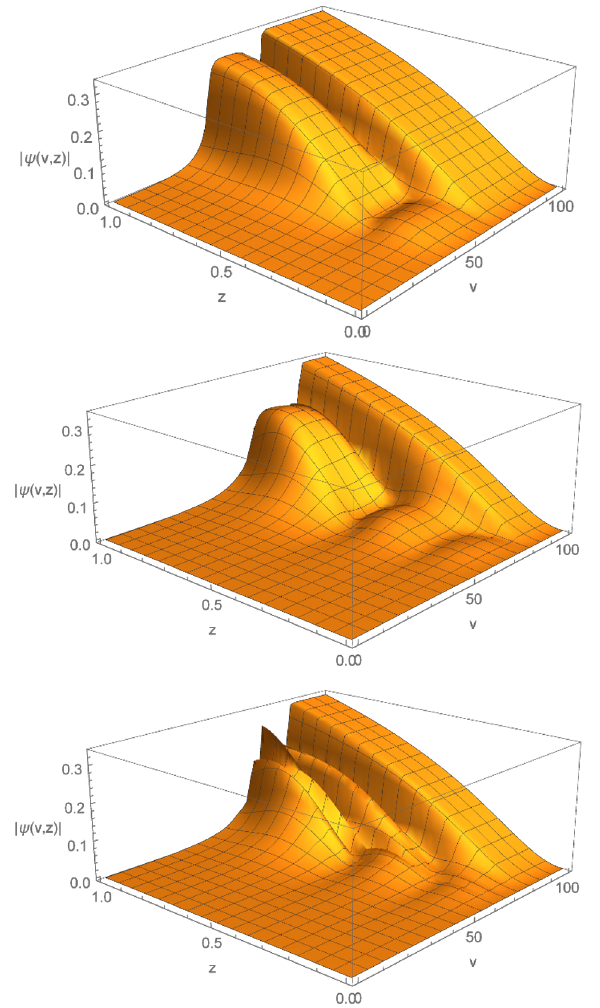
Figure 7 . The dynamics of the scalar field for Q = 3 . 4 and q = 6 . In the three panels, the initial perturbation are taken as the second eigenfunction ψ the superposition ψ mix of the second and the third